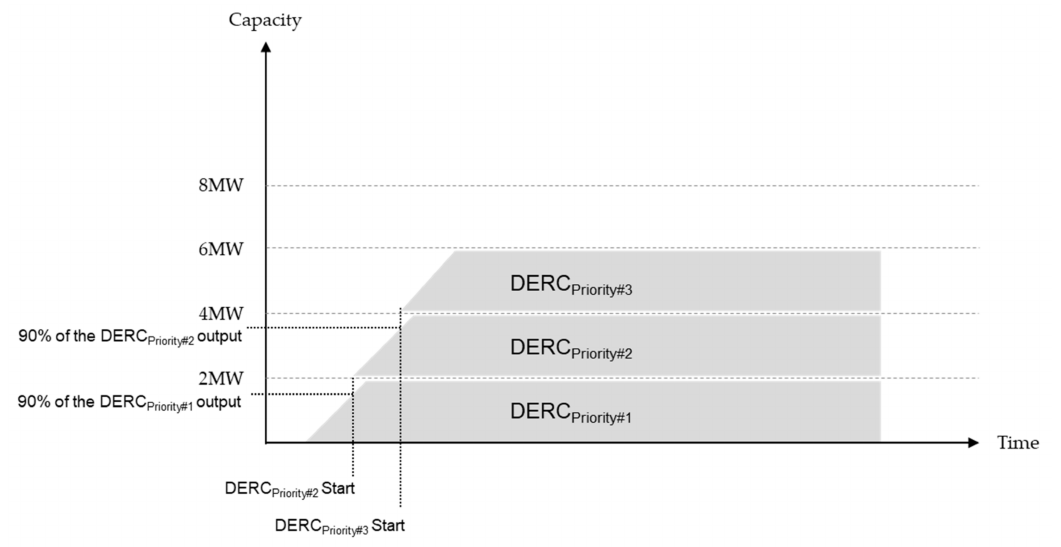
Figure 9. 6 MW charging/discharging operation scheme based on DERC